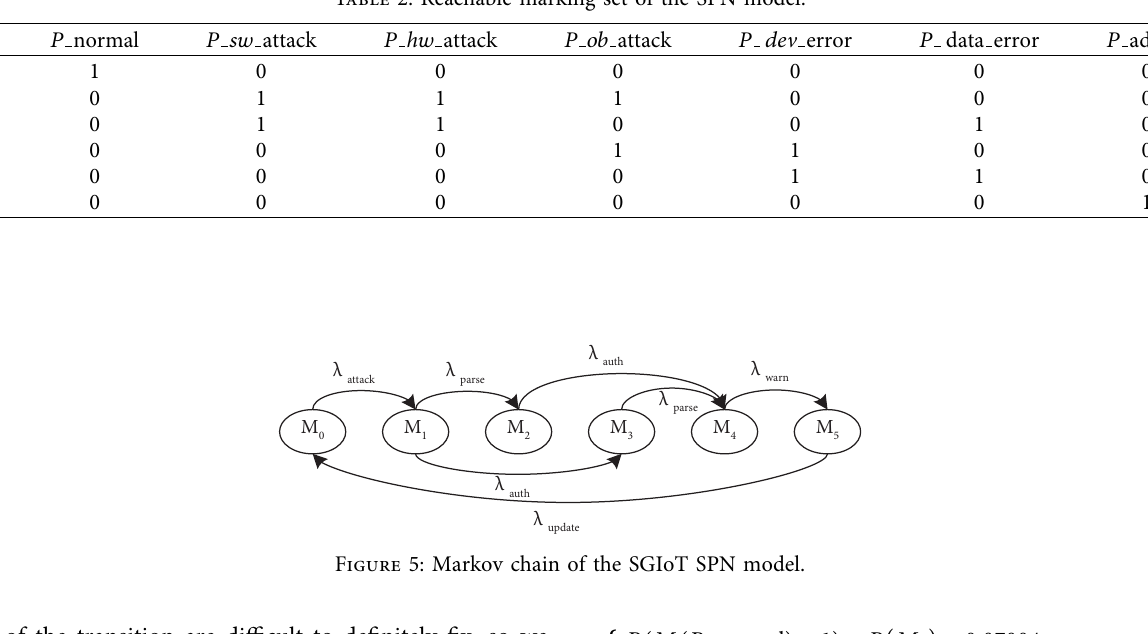
Table 2: Reachable marking set of the SPN model.